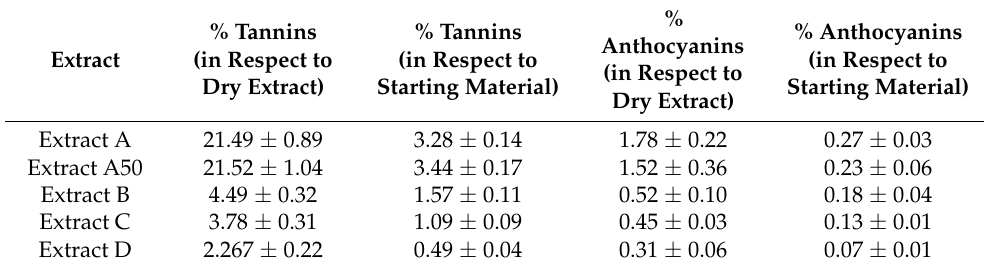
Table 3. Tannins and anthocyanins content calculated in respect to the dry extracts and to the start- ing material.